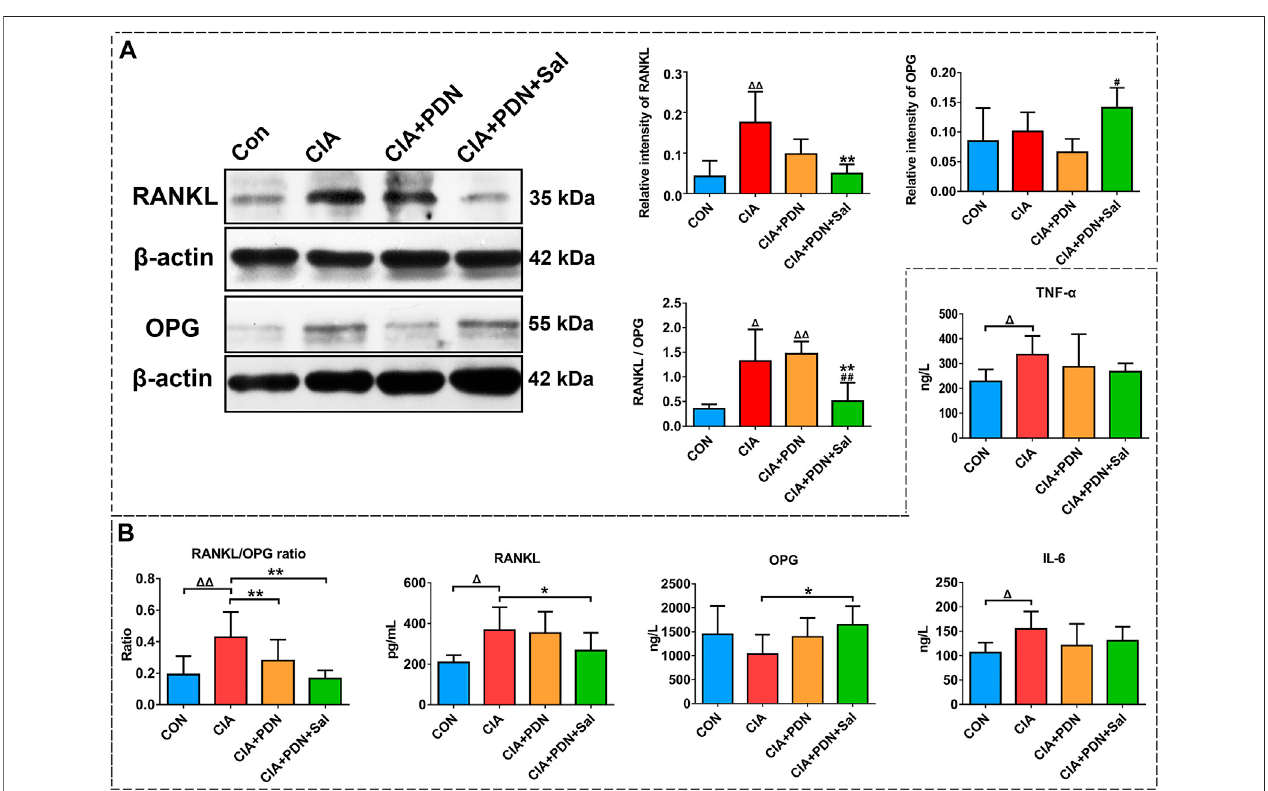
FIGURE 4 | Western blot analysis of RANKL and OPG expression in the hind ankle (A) and serum biomarker analysis (B) in different groups of rats. ΔΔ p < 0.01 vs. CON, ** p < 0.01 vs. CIA, # p < 0.05 vs. CIA+PDN ( n (cid:1) 7).